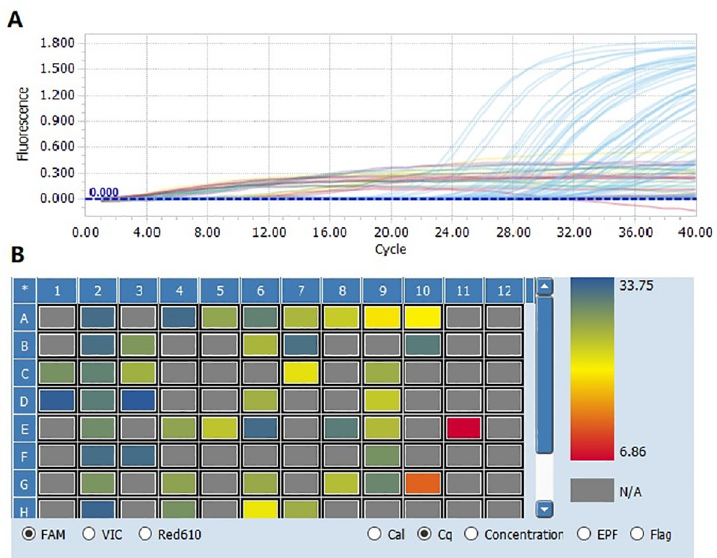
Fig 1. FTSV RNA assessed through RT-PCR assay of partial suspected